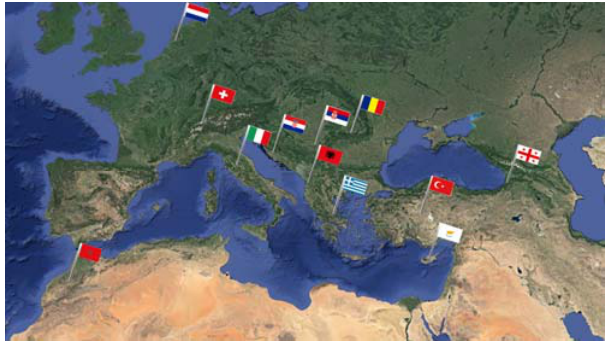
Figure 2. IASON consortium